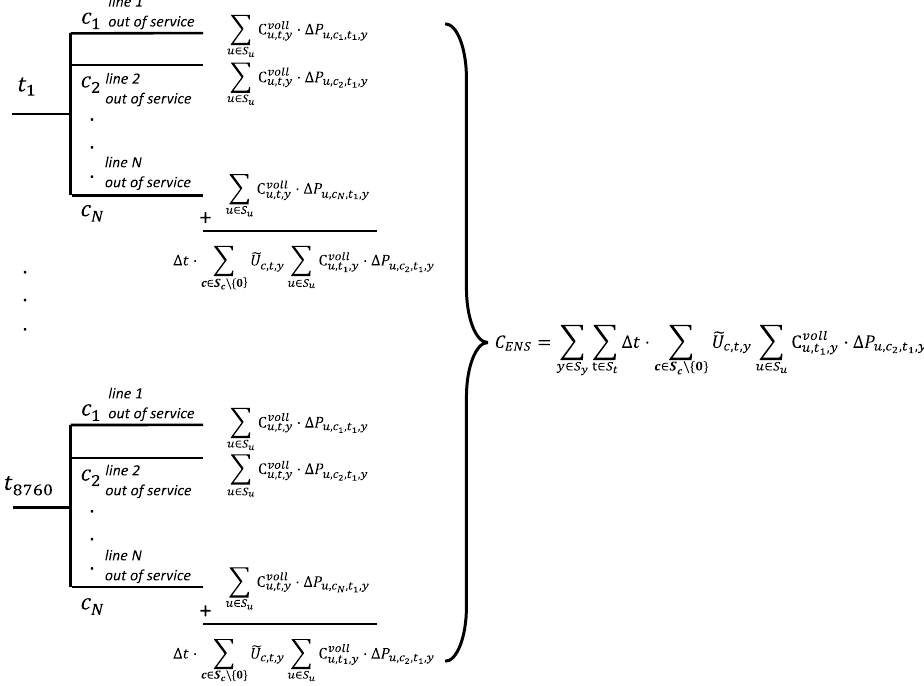
Figure 2. Reliability modelling within the FlexPlan model.